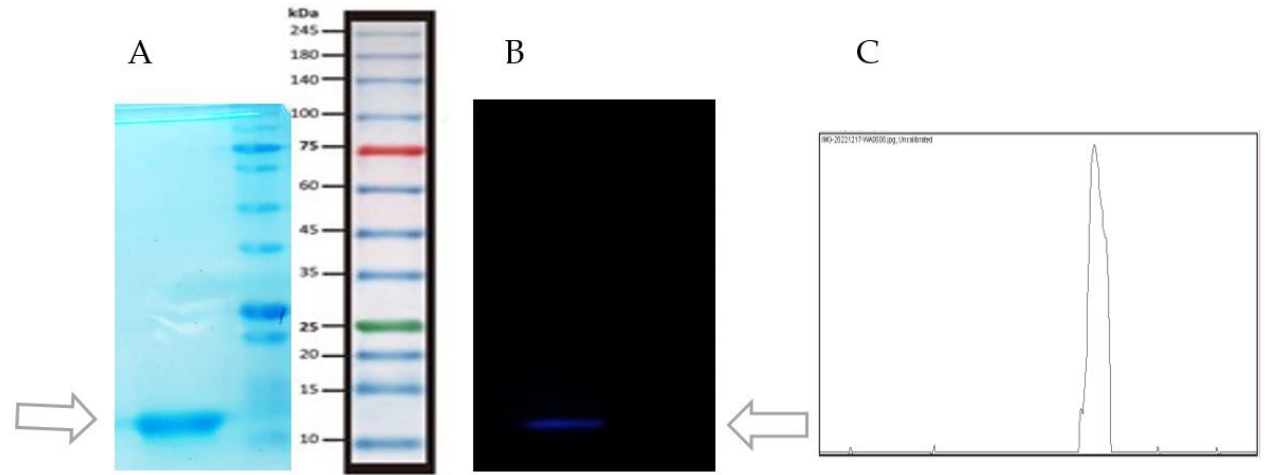
Figure 2. ( A ): A 12 kDa band was detected on SDS polyacrylamide 15% gel. ( B ): P1 protein with His-Tags interacts with anti-His monoclonal antibody in Western blot analysis. ( C ): Plot of the 12 kDa band in Western blot analysis, created with Image J (2.4% area).